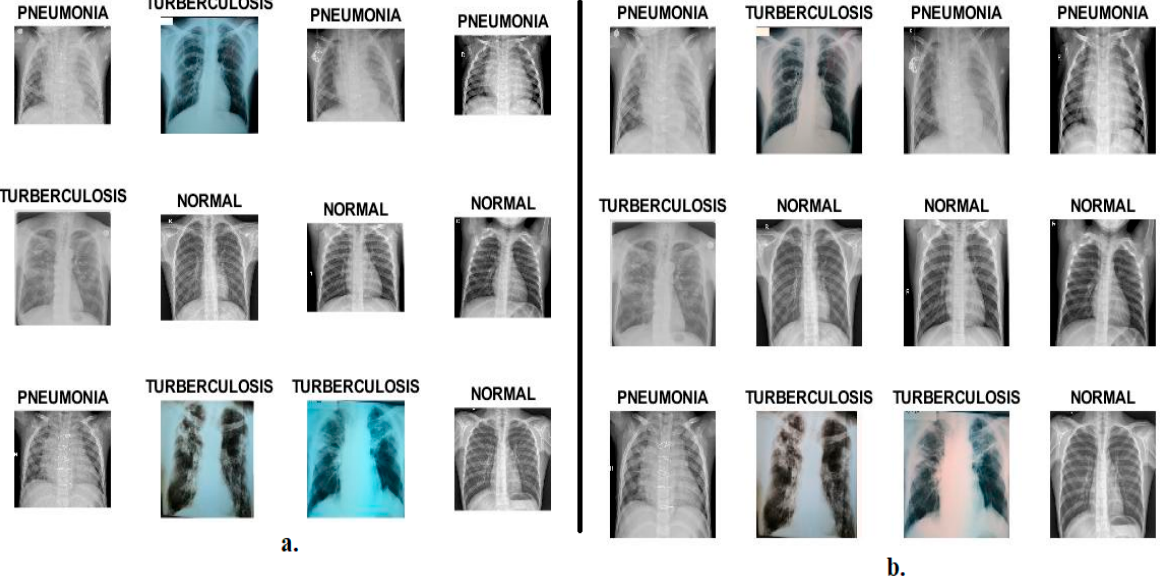
Figure 2. Samples from the pneumonia and tuberculosis data set. ( a ). Before improving the X ‐ rays. ( b ). After improving the X ‐ rays.